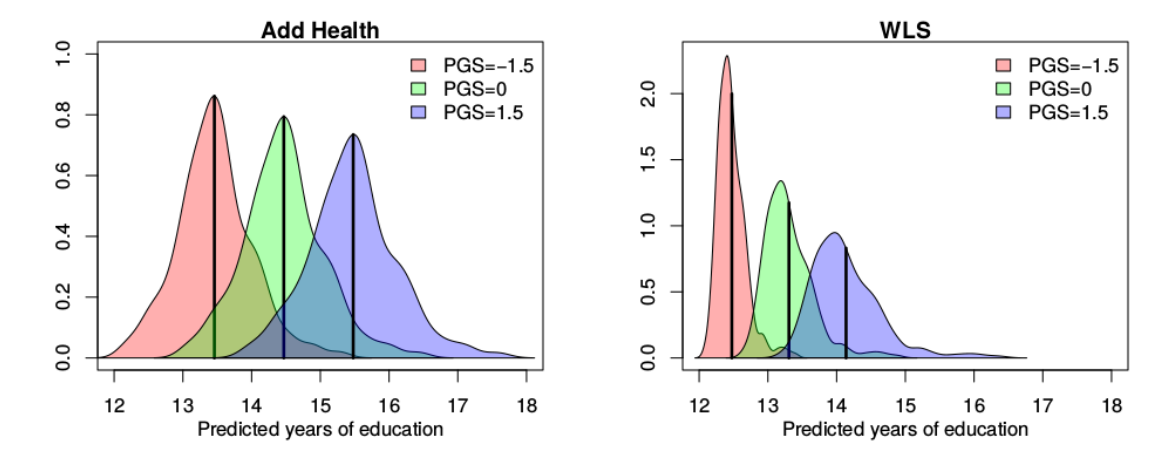
Figure 4: Distribution of predicted years of education across schools for fixed values of the educational attainment polygenic score (PGS). WLS, Wisconsin Longitudinal